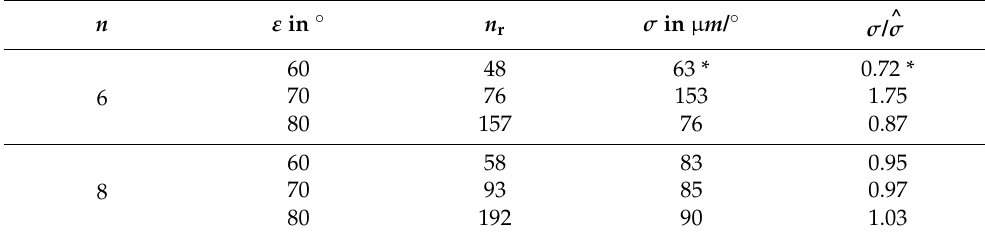
Table 1. Number of reflections n r local sensitivity σ and gain factor σ /ˆ σ at ϕ = 0 for different numbers of faces n and coupling angles ε .